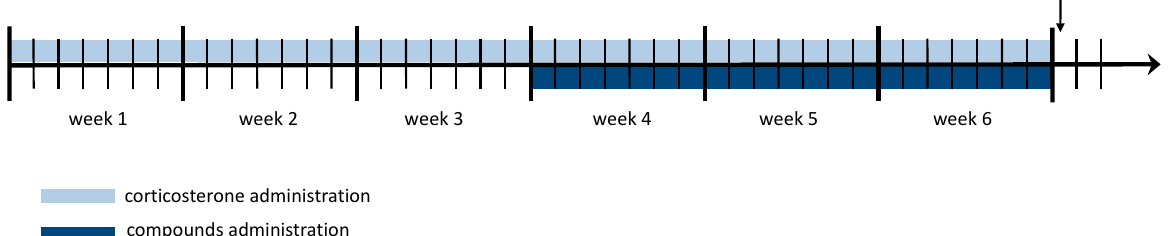
Figure 8. Schematic diagram of experimental design (corticosterone-induced model of depression) Corticosterone or vehicle were injected sc to mice for 3 weeks at random times during the light phase. During the next 3 weeks, 30 min before the corticosterone administration, mice were ip injected with HBK-10 (0.625 or 1.25 mg/kg), fluoxetine (15 mg/kg), or saline. 24 h after the last compounds’ administration, the behavioral tests were performed. FST—forced swim test; LA—locomotor activity.